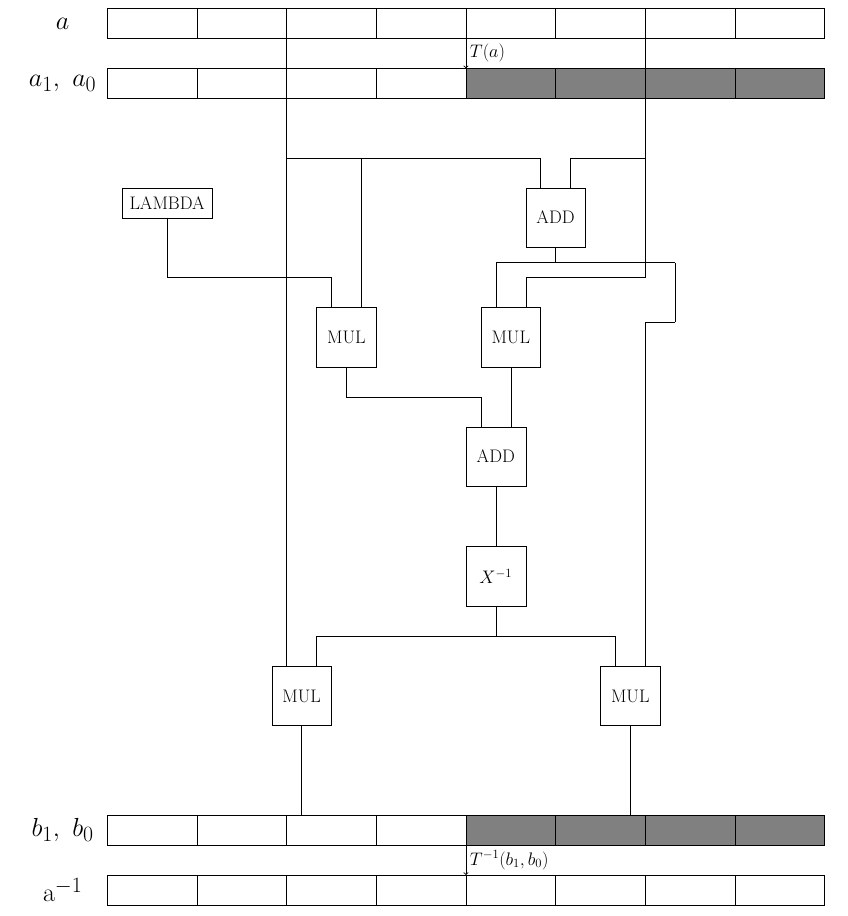
Figure 4. Block diagram of the matrix inversion: One 8-bit value is split into two 4-bit registers. The inverse operation is carried out through the multiplication of each 4-bit value with its reciprocal in GF ( 2 4 ) , which is obtained from a lookup table. The resulting two 4-bit values are reorganized using bit arrangements to obtain the 8-bit inverse